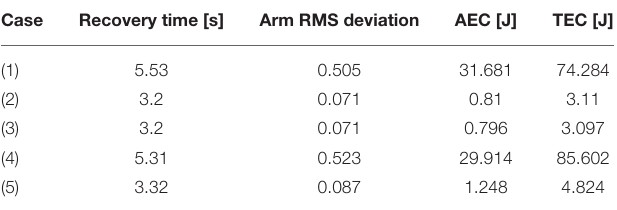
TABLE 3 | Contributions of active arm usage to balance recovery under different ankle capacities.